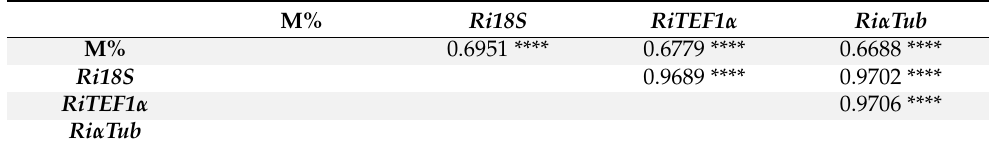
Table 2. Spearman’s rank correlation coefficients between constitutively expressed Rhizophagus irregularis genes and mycorrhization intensity